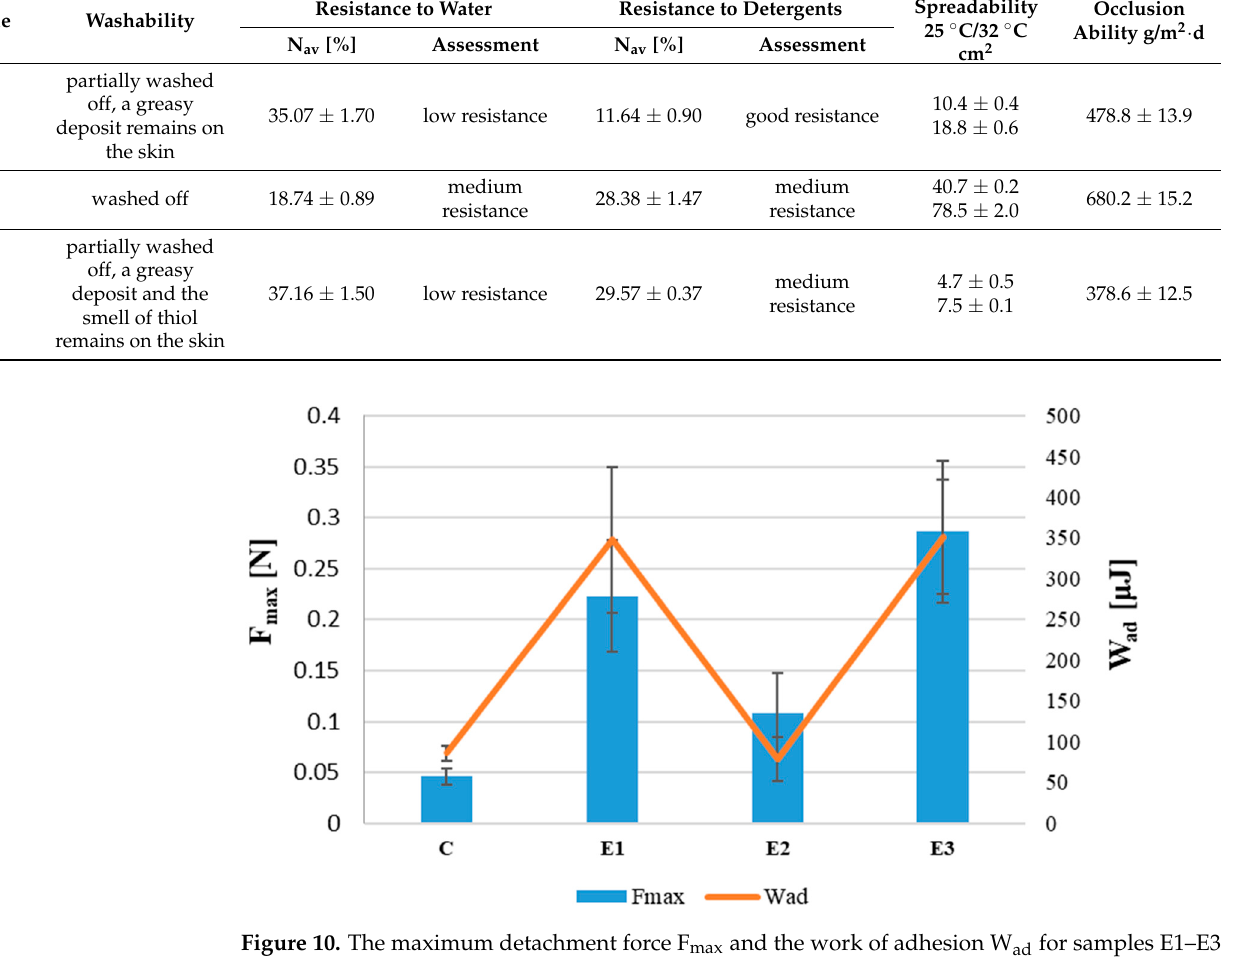
Figure 10. The maximum detachment force F max and the work of adhesion W ad for samples E1–E3 and negative control (cellulose paper, sample C).